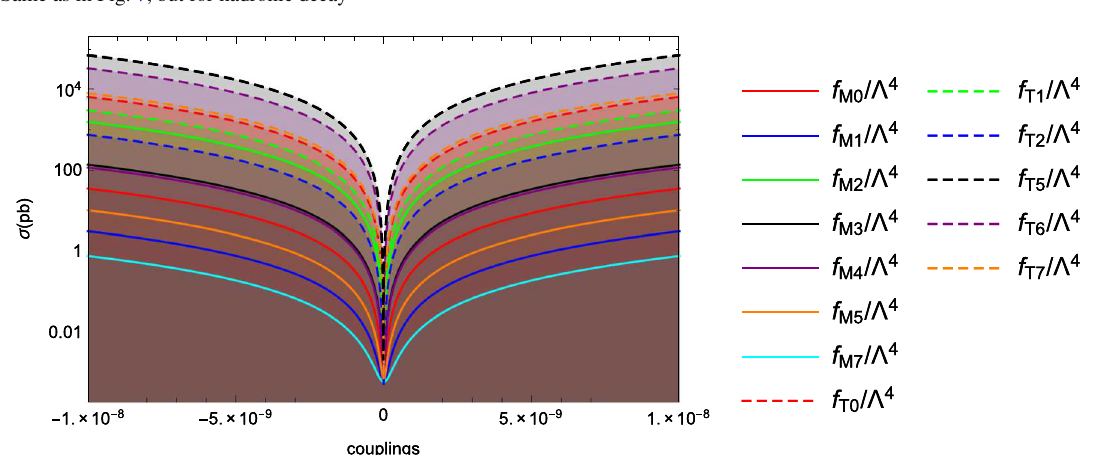
Fig. 9 Same as in Fig. 7, but for hadronic decay